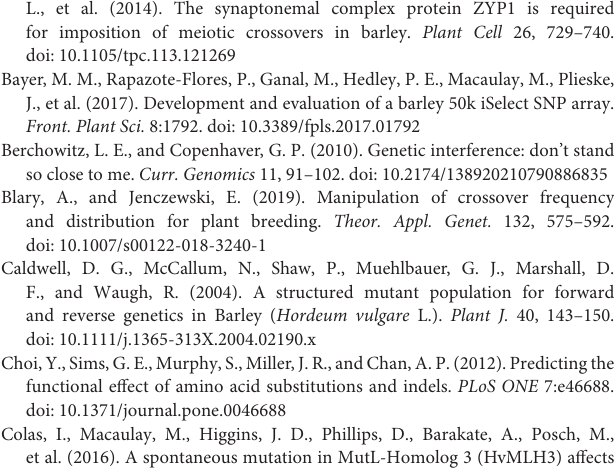
synapsis and crossover resolution in the barley desynaptic mutant des10. New Phytol. 212, 693–707. doi: